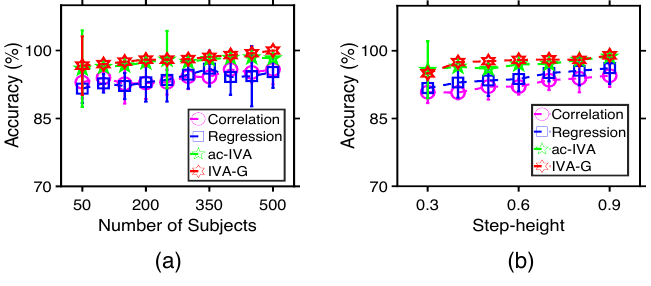
Figure 5. Accuracy performance of correlation, regression, ac-IVA, and IVA-G to identify the profiles correlated with the behavioral features for different ( a ) numbers of subjects and ( b ) step-heights. The components and their corresponding profiles are estimated using IVA. Performances of all the methods improve with the number of subjects and step-heights. All the results are averaged over 100 independent